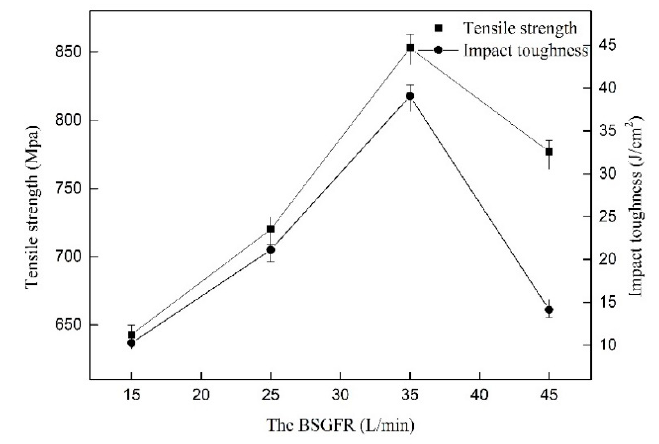
Figure 7. The cross section of welded joints at the different BSGFR; ( a ) 15 L/min; ( b ) 25 L/min; ( c ) 35 L/min; ( d ) 45 L/min.